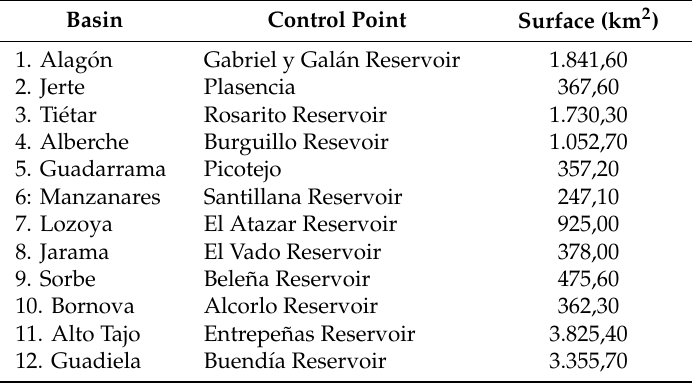
Figure 2. Headland sub-basins included in the ERHIN program in the Tagus basin. Table 1. ERHIN zones in the Tagus Basin, where ASTER is operational.